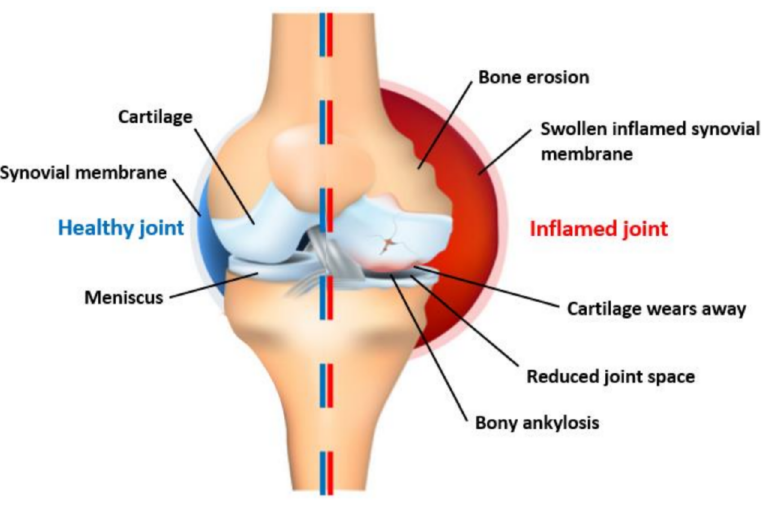
Figure 1. Rheumatoid arthritis (RA) joint